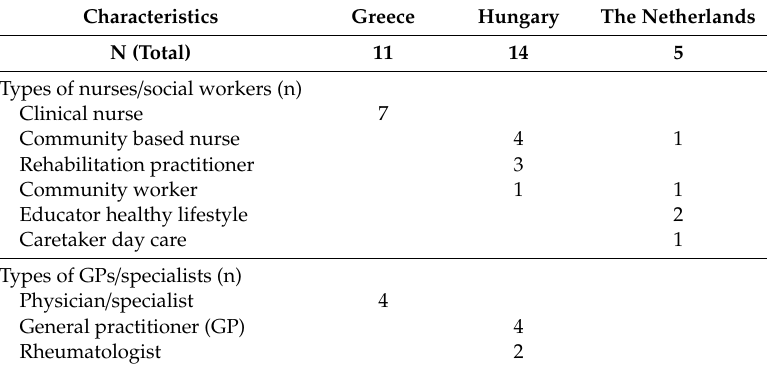
Table 4. Characteristics of the participating health